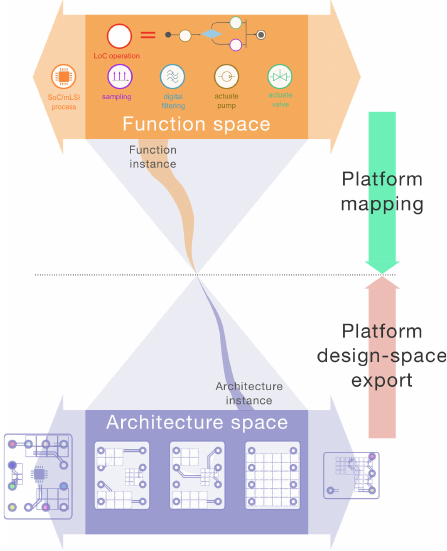
Figure 1. CPS PBD in an uncertain environment. Changing context and requirements may